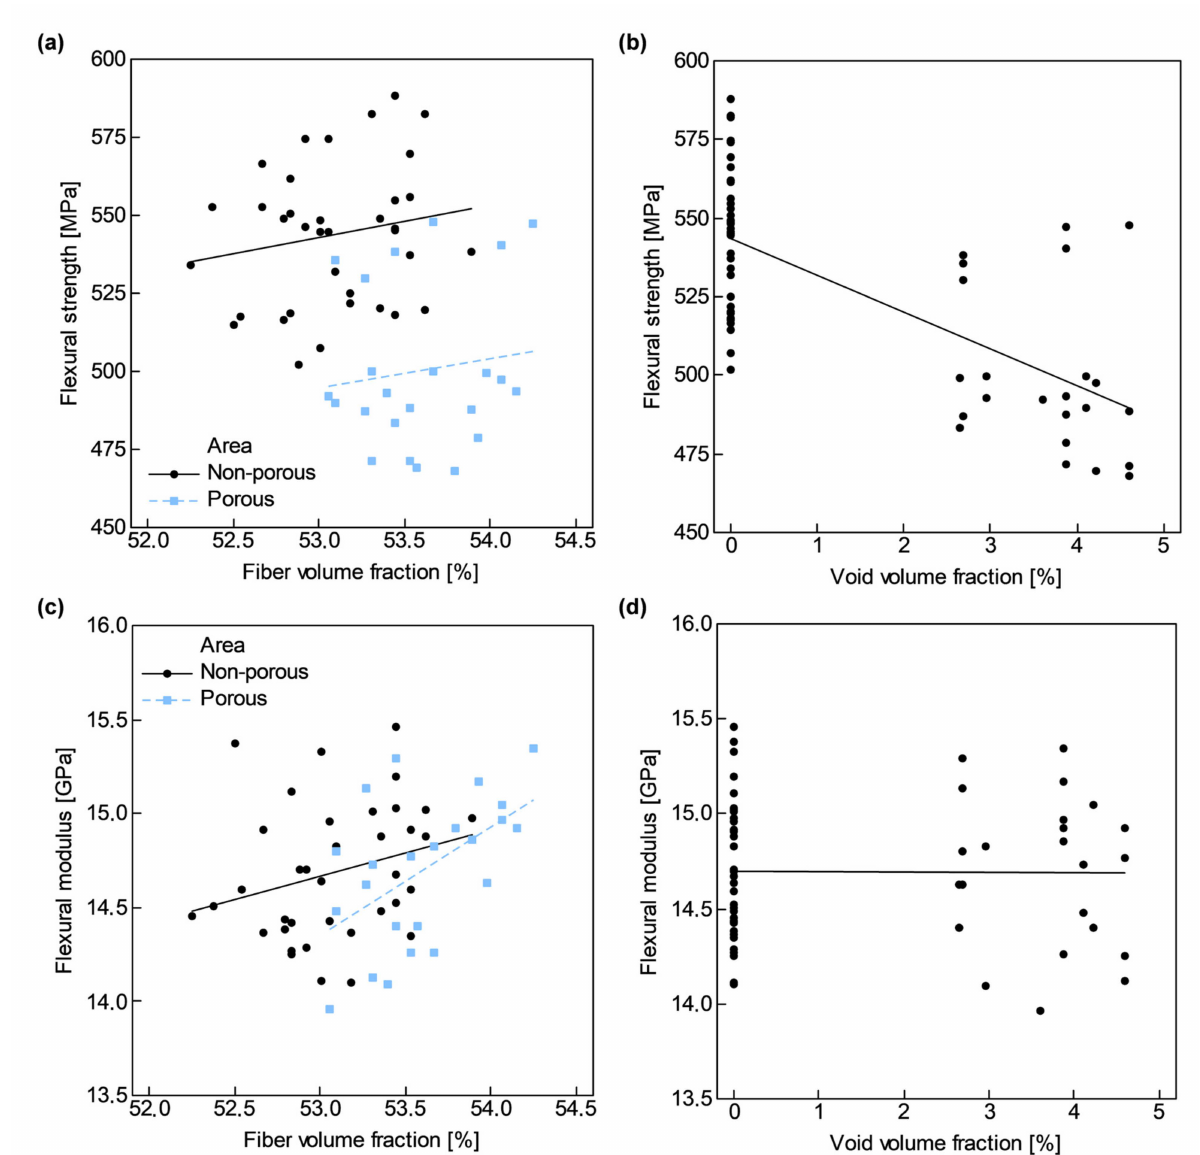
Figure 11. Flexural properties versus estimated fiber volume fraction, ˆ v (cid:48) strength, σ fM ; and ( c , d ) Flexural modulus, E f